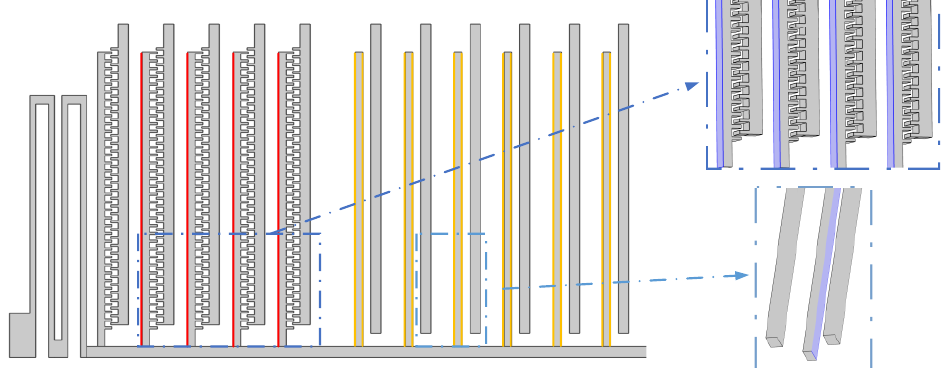
Figure 4. Viscous damping model: ( a ) slide film damping model; ( b ) squeezing film damping model [28].